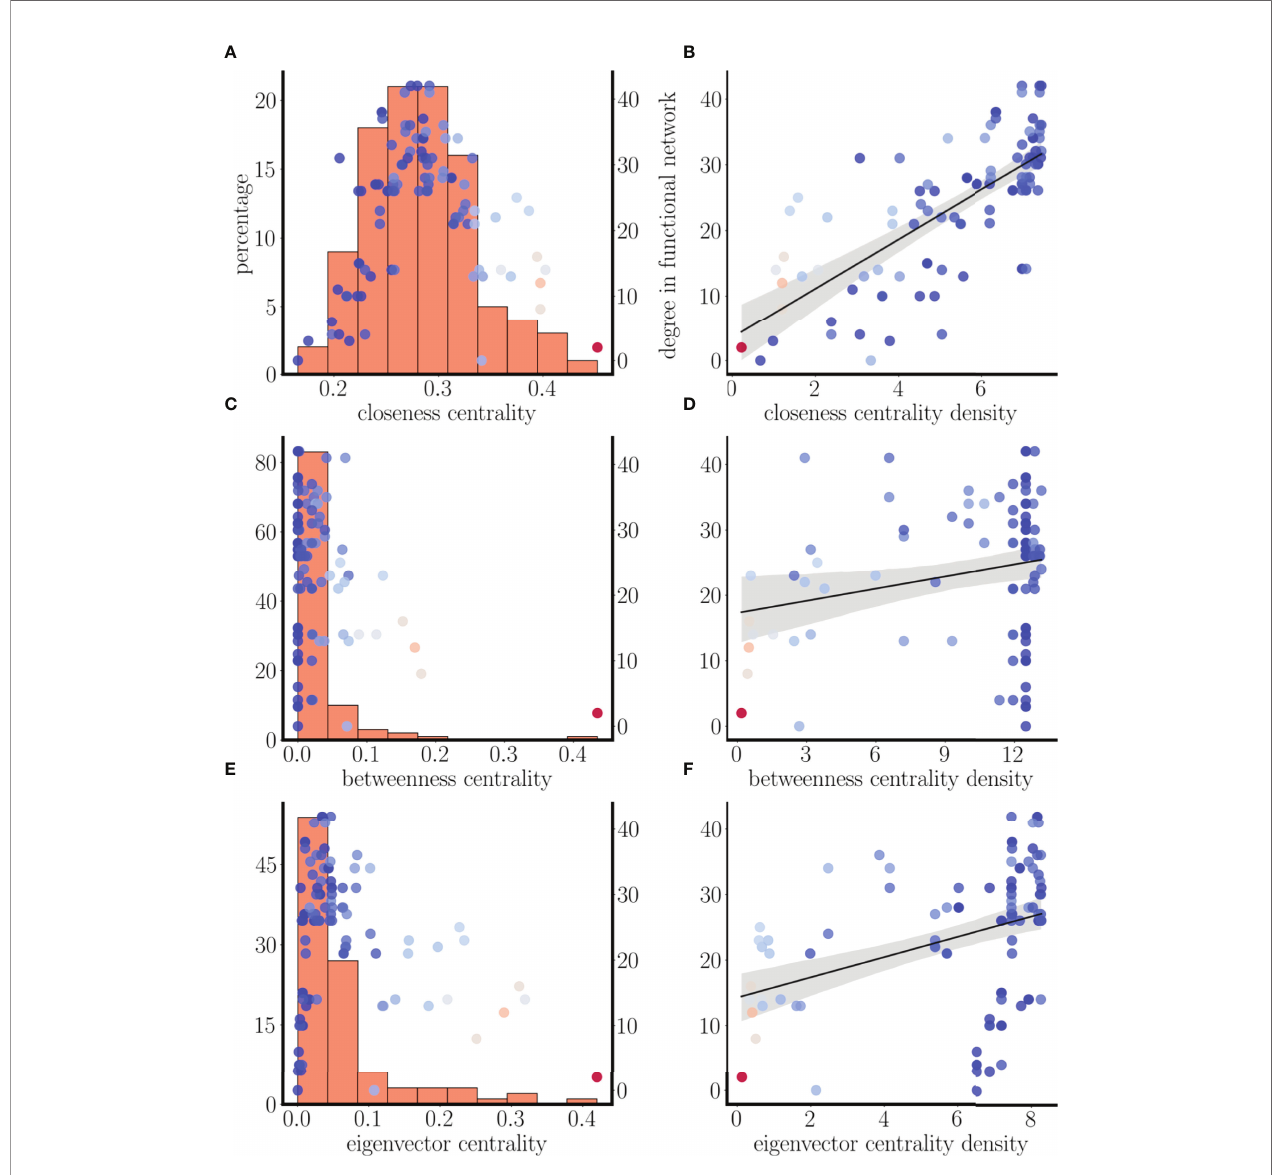
FIGURE 12 | Positive correlation between functional degree and closeness centrality with similarity threshold of S ij >0.85. (A, C, E) As in Figure 11 , but with a lower similarity threshold. (B, D, F) Scatter plots of degree of the nodes in the functional network vs. closeness, betweenness, and eigenvector centrality densities. For this set of initial conditions, there is a correlation of 0.72 with p-value <0.005 for closeness centrality density, but no correlation with the other measures of structural degree. In panel B, the node color re fl ects the closeness centrality density in the structural network. Many of the red nodes in this network are also red in the functional representation of panel A; the nodes with highest functional degree tend to have similar closeness centrality.